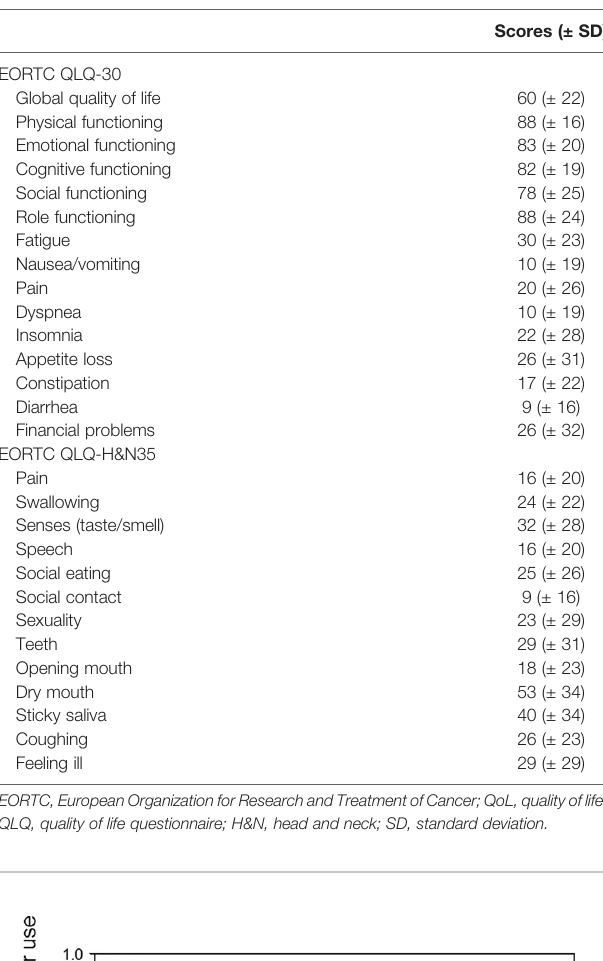
TABLE 2 | The mean scores of the EORTC QoL